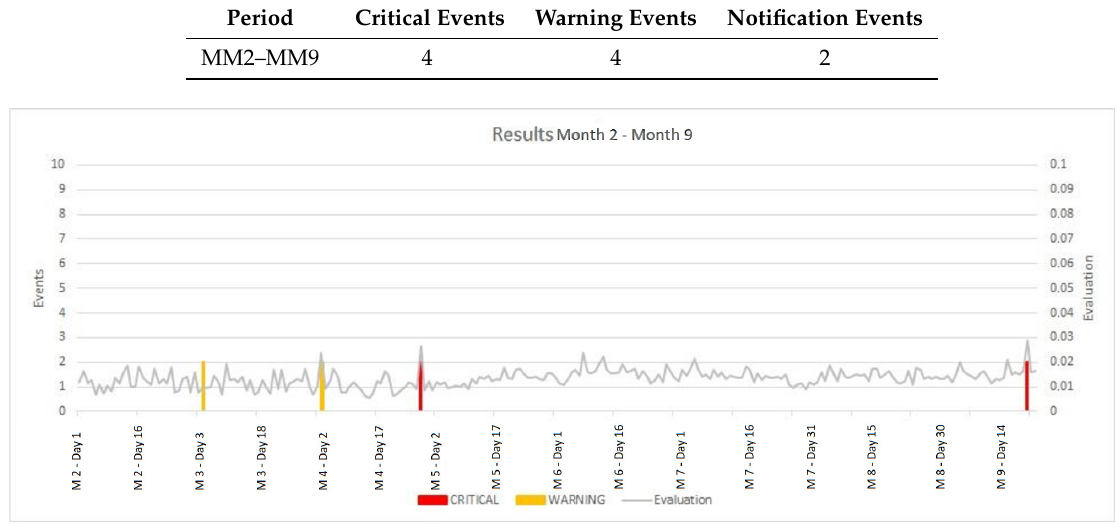
Figure 10. Aggregated evaluation graph and generated alerts (maintenance months MM2 till